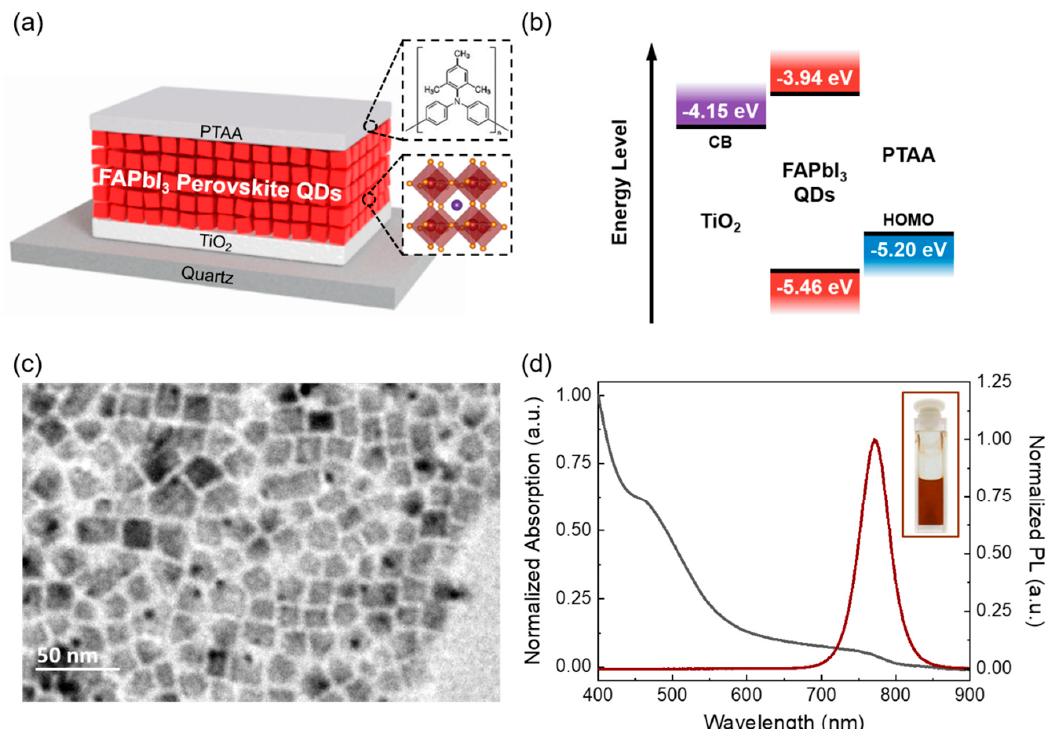
Figure 1. ( a ) The structure of FAPbI 3 PQDs layer grown with PTAA HTL and TiO 2 ETL; ( b ) energy levels of TiO 2 , FAPbI 3 PQDs, and PTAA used in this work; ( c ) transmission electron microscope (TEM) image of pure FAPbI 3 PQDs film; ( d ) normalized UV − vis absorption spectra and PL spectra of FAPbI 3 PQDs solutions.